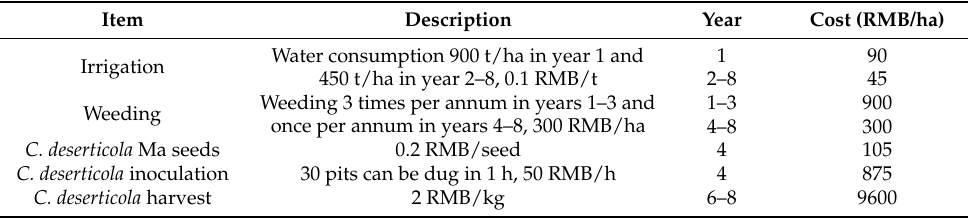
Table 2. Management, inoculation, and collection costs for planting H. ammodendron [30–33].